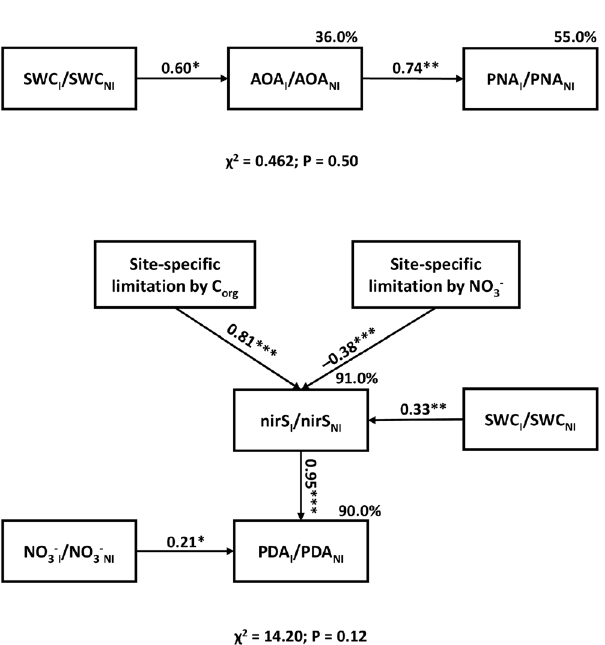
Figure 3. Structural equation models identifying probable causal effects of inoculation on (de)nitrification. Structural equation models identifying probable causal effects of inoculation on (Top) potential nitrification activity, PNA, and (Bottom) potential denitrification activity, PDA. The full models tested are presented in Fig. S8. For soil ammonium, NH 4 + , nitrate, NO 3 − , and water content, SWC, potential activities (PNA and PDA) and gene abundances (AOA and nirS -denitrifiers), the effect of inoculation (%) was computed as [(I)/ NI − 1] * 100. The proxies of the site-specific levels of denitrification limitation by C and N were computed from PDA and semi-potential denitrification activity measured when only N or C, respectively, were added. Path coefficients (values near the arrows) correspond to the standardized coefficients based on the analysis of correlation matrices. Significant relationships ( * P < 0.05; ** P < 0.01; *** P < 0.001) are indicated with solid arrows. For activities and gene abundances, the percentages of variance explained by the model are